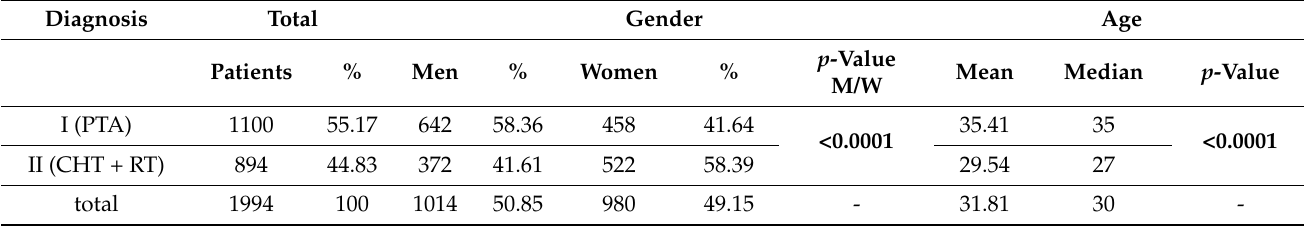
Table 1. Age and gender characteristics of the patient